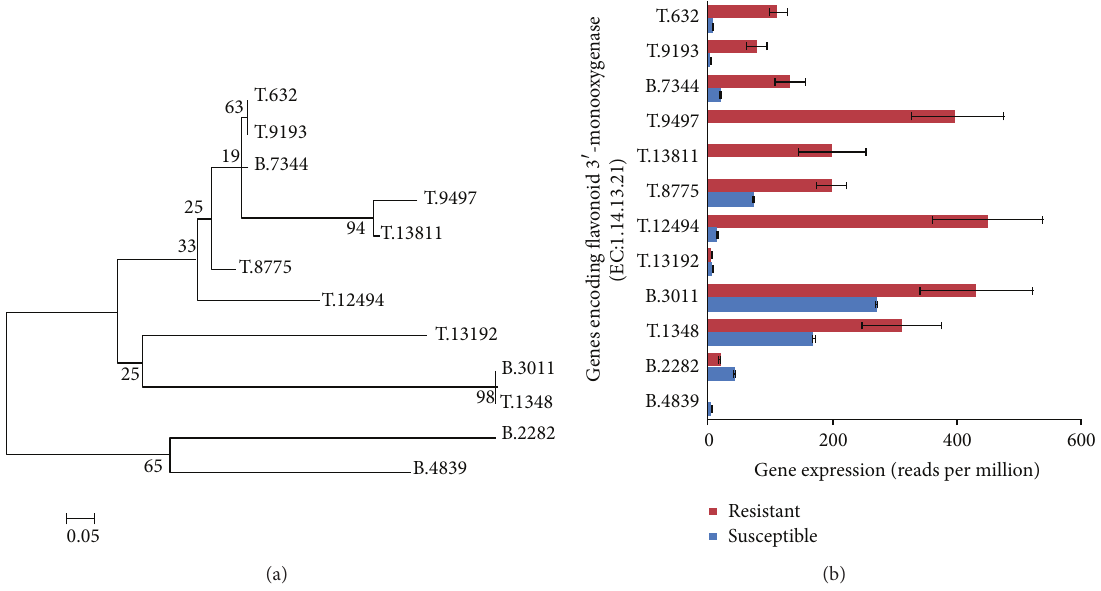
Figure 7: (a) Phylogenetic distance of unigenes encoding flavonoid 3 󸀠 -monooxygenase to produce flavonoids. (b) Comparison of transcripts abundance (reads per million, RPM) assembled unigenes encoding flavonoid 3 󸀠